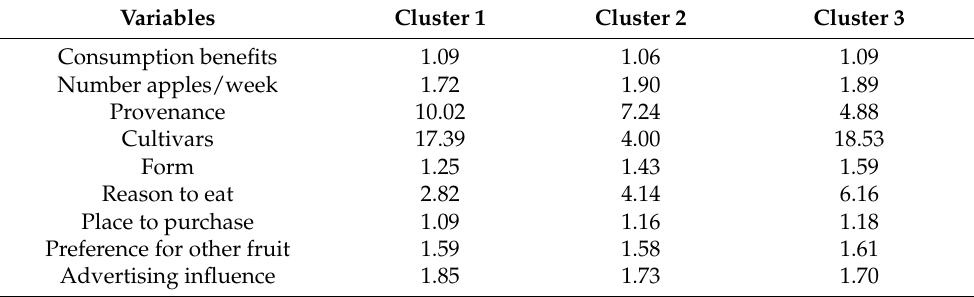
Table 5. Cluster membership within observations of the categories.